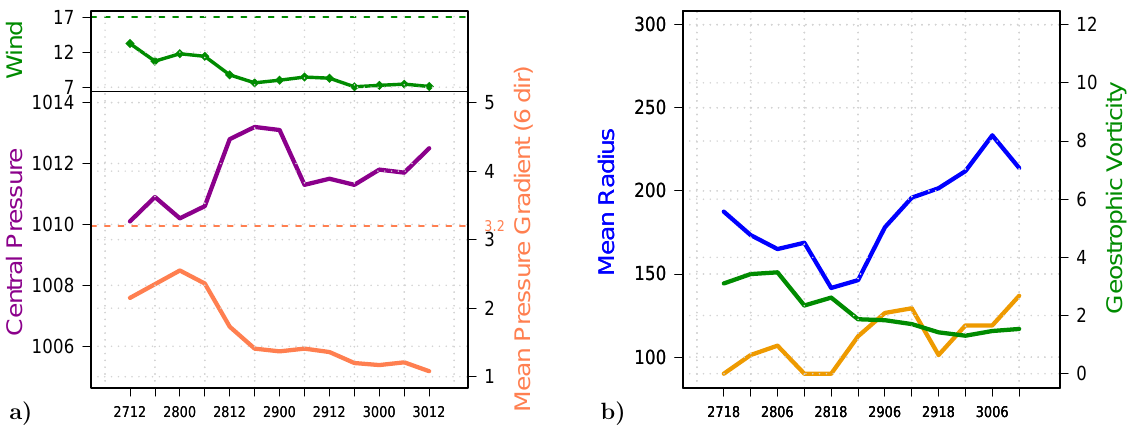
Fig. 4. Evolution over time of (a) gradient wind (ms − 1 ) in green (top) and central pressure (hPa) in violet + Mean pressure gradi- ent (10 − 2 hPakm − 1 ) in orange (bottom); (b) mean radius (km) in blue + mean warm core radius (km) in orange + geostrophic vorticity (10 − 4 s − 1 ); for 1983 event.